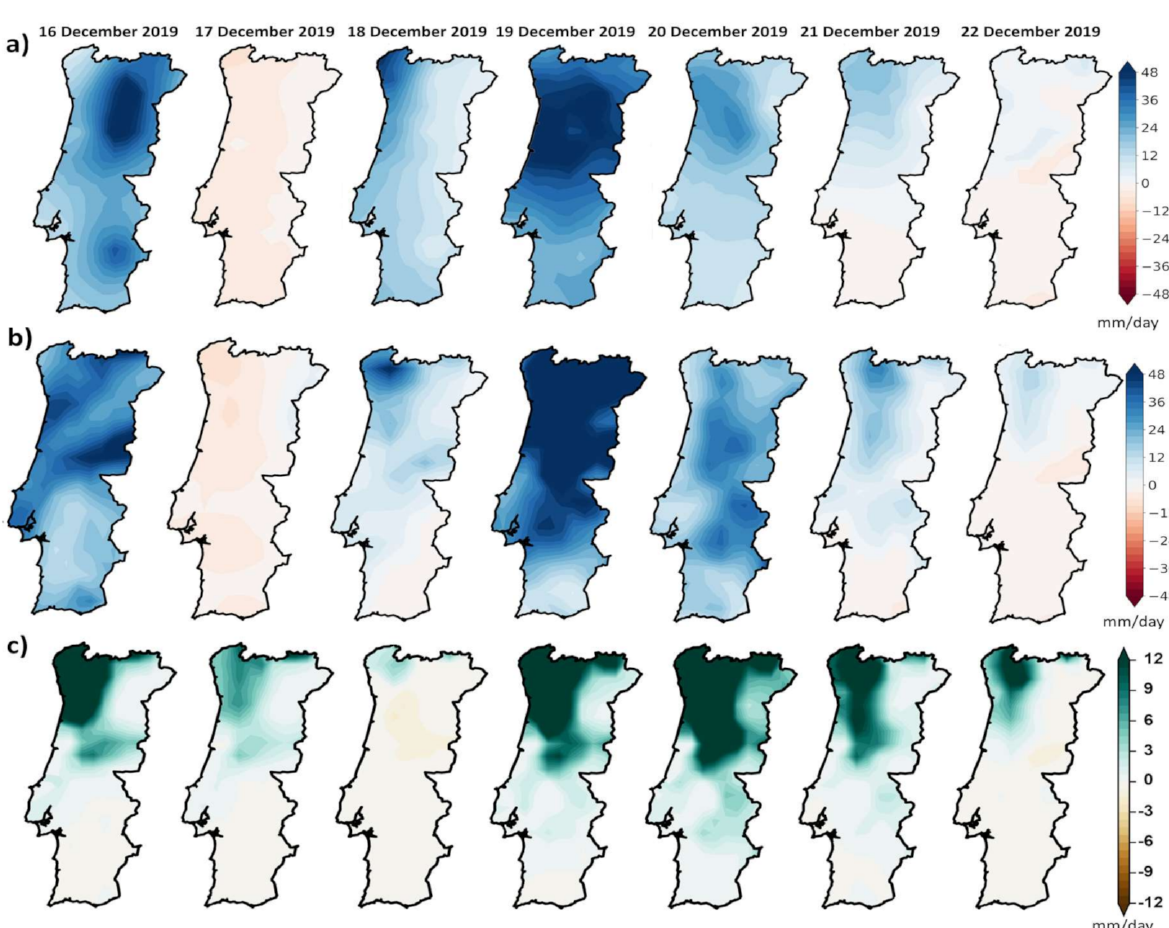
Figure 6. Precipitation anomaly (mm/day) calculated using EOBS data ( a ) ERA5 data ( b ) and runoff anomaly (mm/day) ( c ) during Daniel, Elsa, and Fabien storms from 16 to 22 December